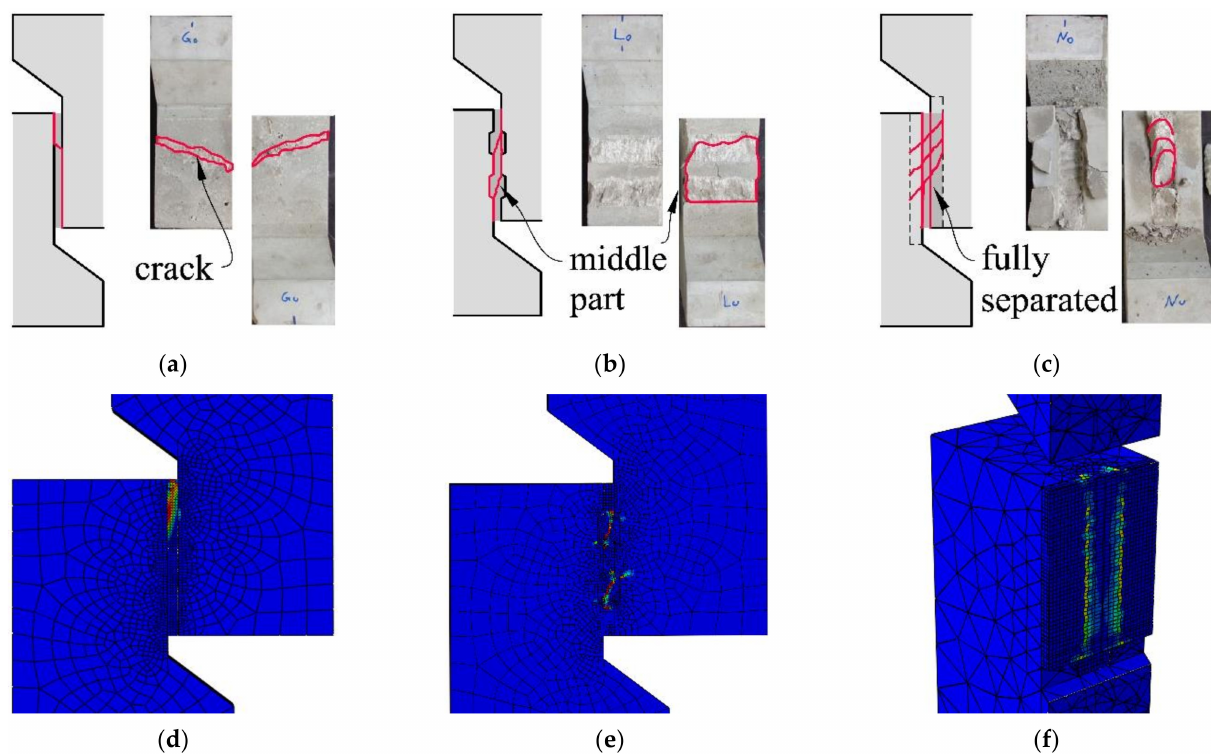
Figure 16. Typical cracking pattern for different joint types: ( a ) VG (plain); ( b ) VL (keyed); ( c ) VN (grooved). Comparison to the FEM results: ( d ) plain, ( e ) keyed, ( f )